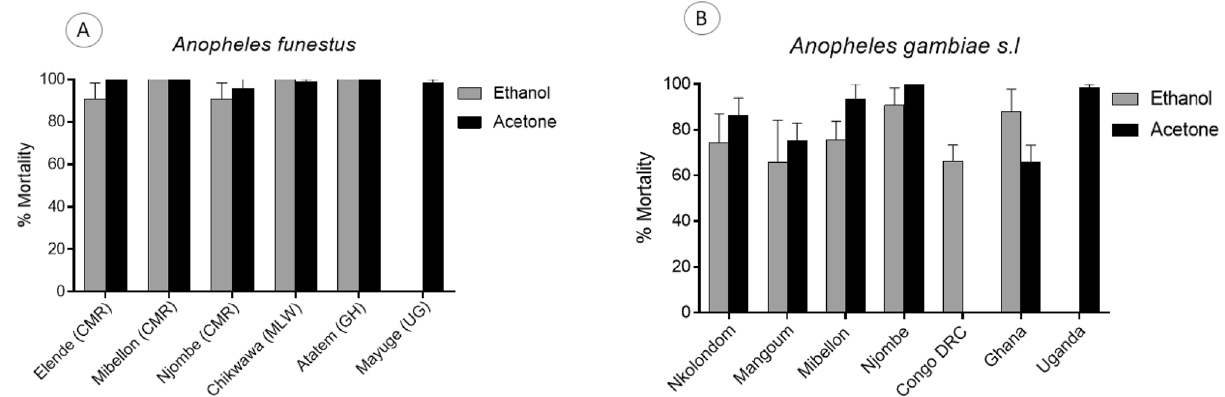
Figure 3. Susceptibility profile of An. funestus and An. gambiae s.l to chlorfenapyr 100 µg/ml across Africa. Mortality rate of An. funestus ( A ) and An. gambiae ( B ) from different sites 72 h after exposure to chlorfenapyr 100